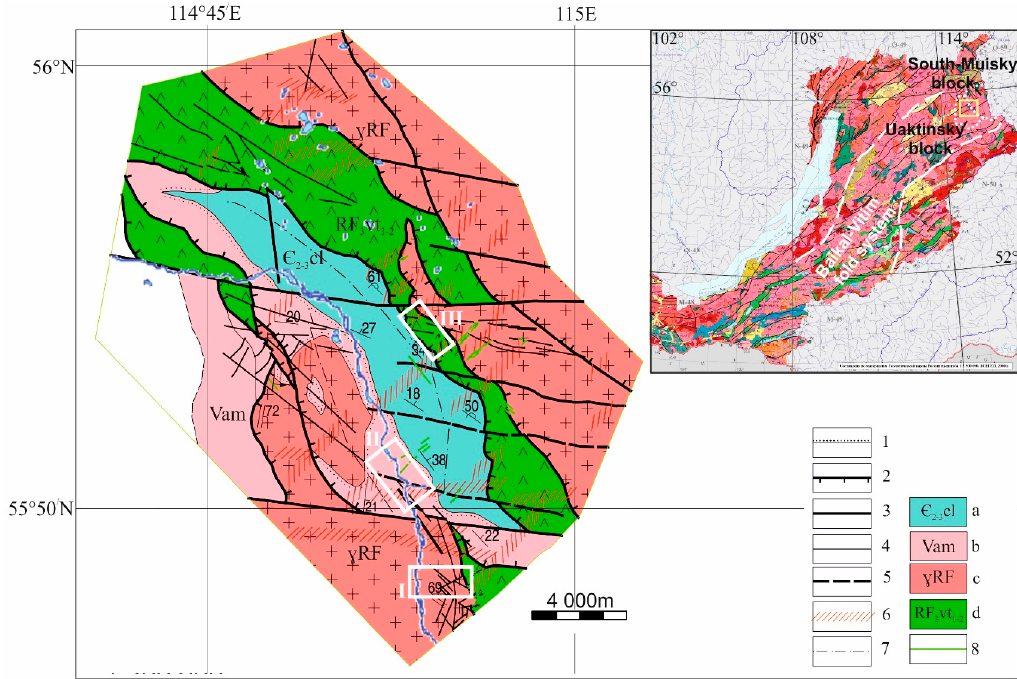
Figure 1. The structural tectonic scheme of the work area (1:200,000). Structural–material complexes (a—Chulegminsky; b—Amatkanskoy; c—Verkhnetuluinsky subvolcanic; and